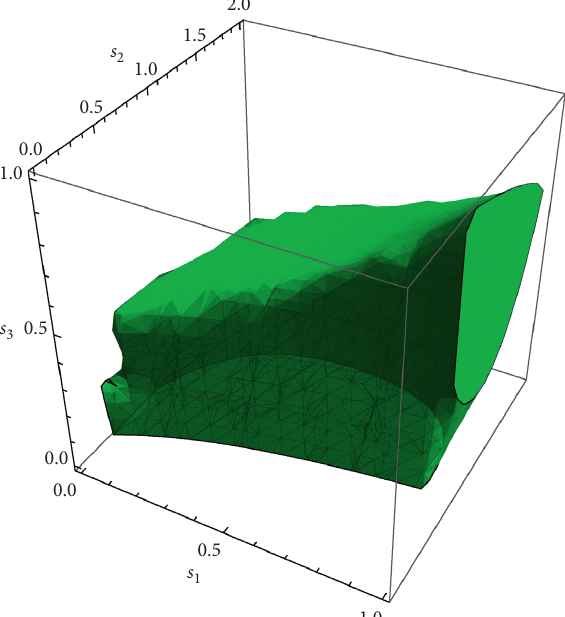
Figure 5: Controllable region (green) for system